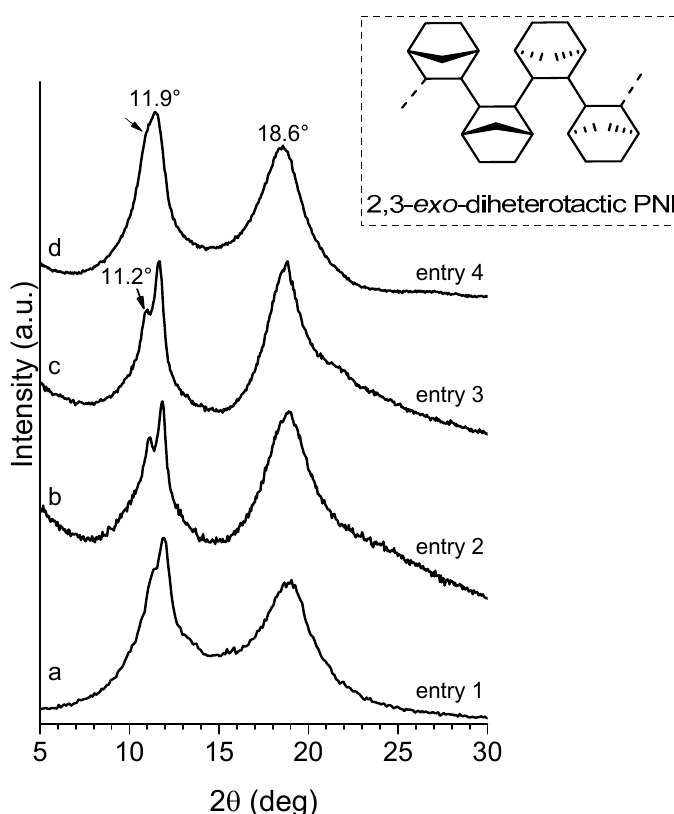
Figure 7. X ‐ ray powder diffraction profiles of the as ‐ prepared NB oligomer samples reported in Figure 7. X-ray powder diffraction profiles of the as-prepared NB oligomer samples reported in